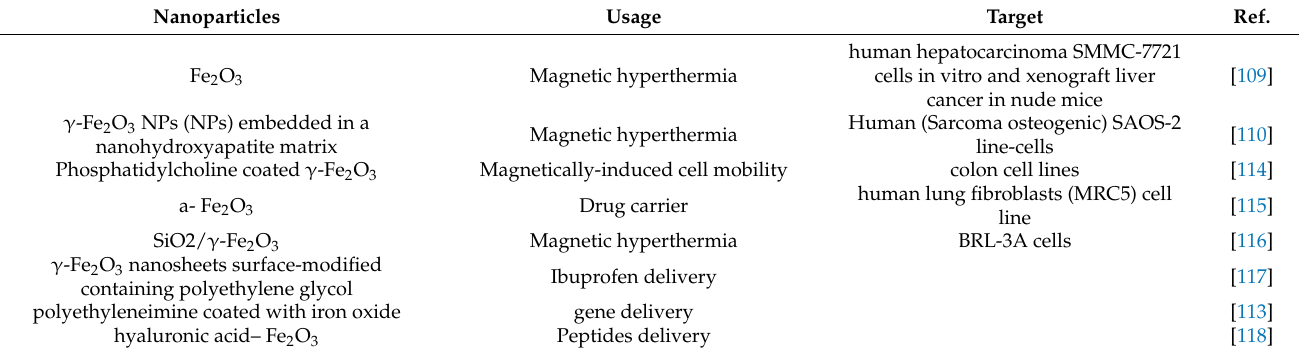
Table 1. Some few biological uses of the newly developed magnetic-responsive devices containing Fe 2 O 3 .